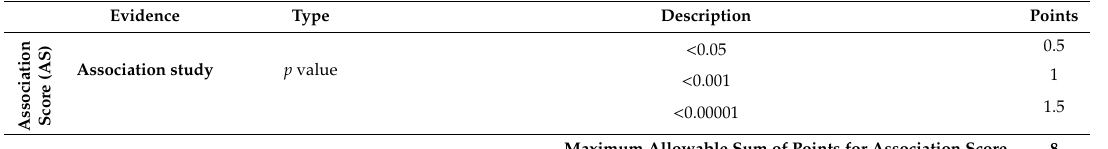
Table 1. The point system used to score available evidence and to calculate the three individual scores (Association Score, Variant Score and Experimental Score) involved in the calculation of IthaScore. The point system was based on a similar approach described in References